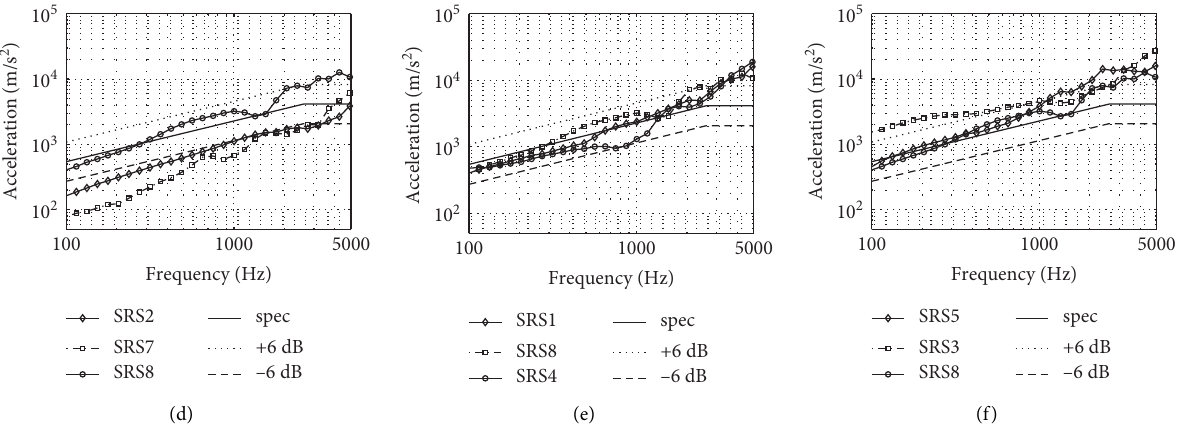
Figure 4: Comparing the three most similar SRS to a target SRS spec using different similarity metrics (database size � 10 channels). (a) MAD, (b) ASR, (c) E R , (d) M R , (e) RMSE, and (f) Δ j .